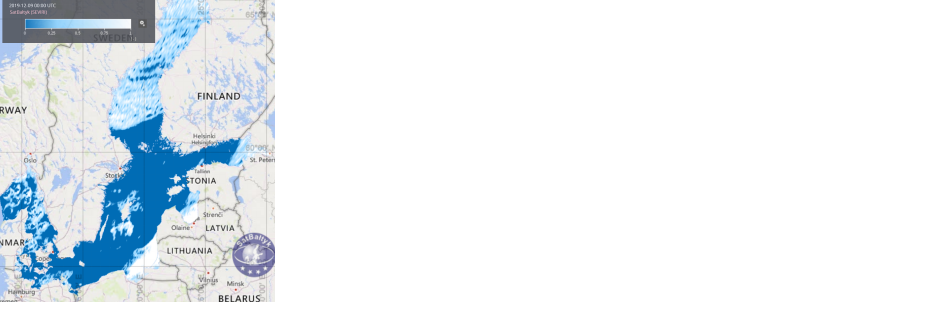
Figure 1. The example of the cloudiness map from 9 December 2019 at 00:00